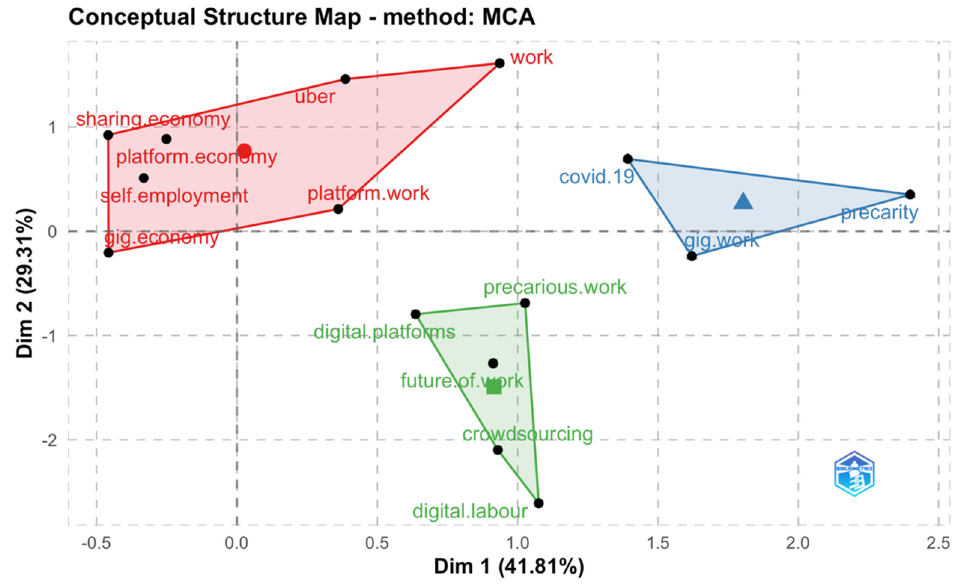
Figure 10. Conceptual structural map.